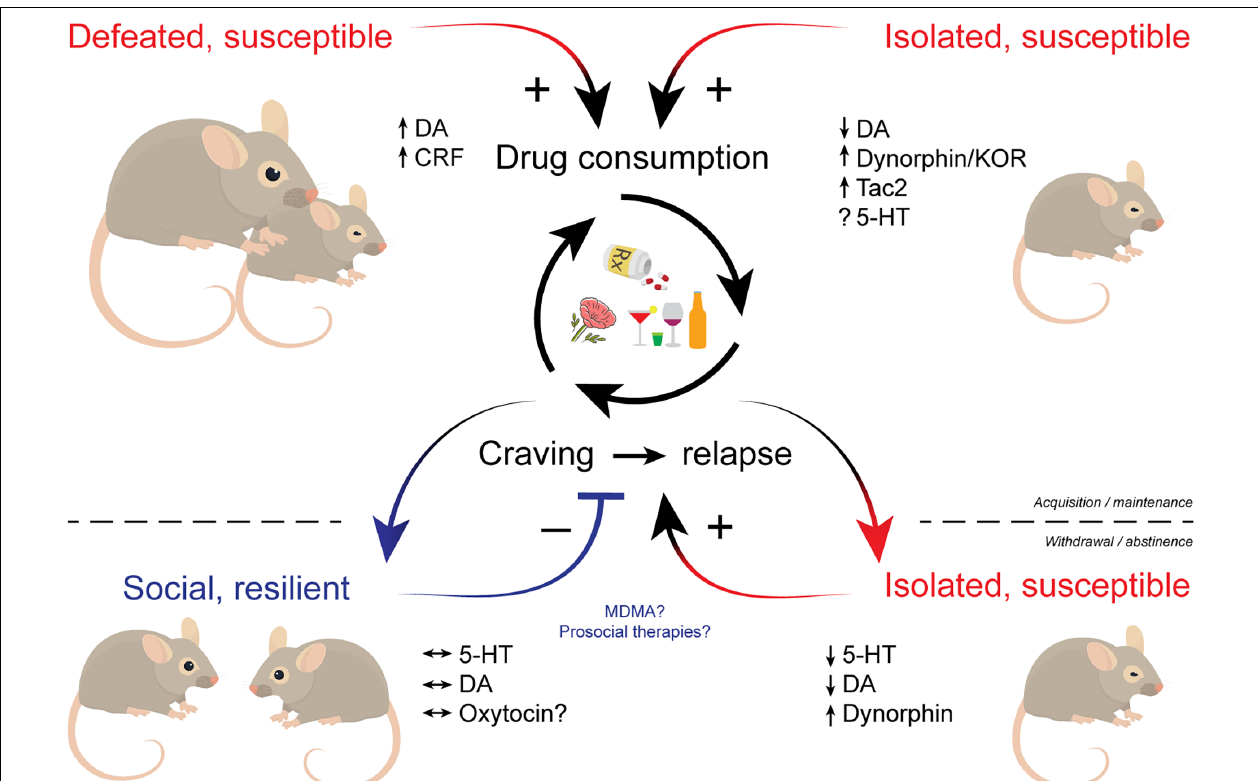
FIGURE 1 | Schematic illustrating the influence of social factors across phases of addiction. Social defeat and social isolation stress facilitate the acquisition and promote the maintenance of drug use. Drug withdrawal and prolonged abstinence promote social isolation that in turn increases susceptibility to drugs. Individuals who maintain proper social drive may be resilient to drug cravings and relapse. Multiple neuromodulators including dopamine, serotonin, and various neuropeptides play key roles in social influences over addictive behaviors. Therapeutic approaches that bolster sociability like MDMA may hold promise in treating SUDs. MDMA, ( ± )3,4-methylenedioxymethamphetamine; SUDs, substance use disorders.